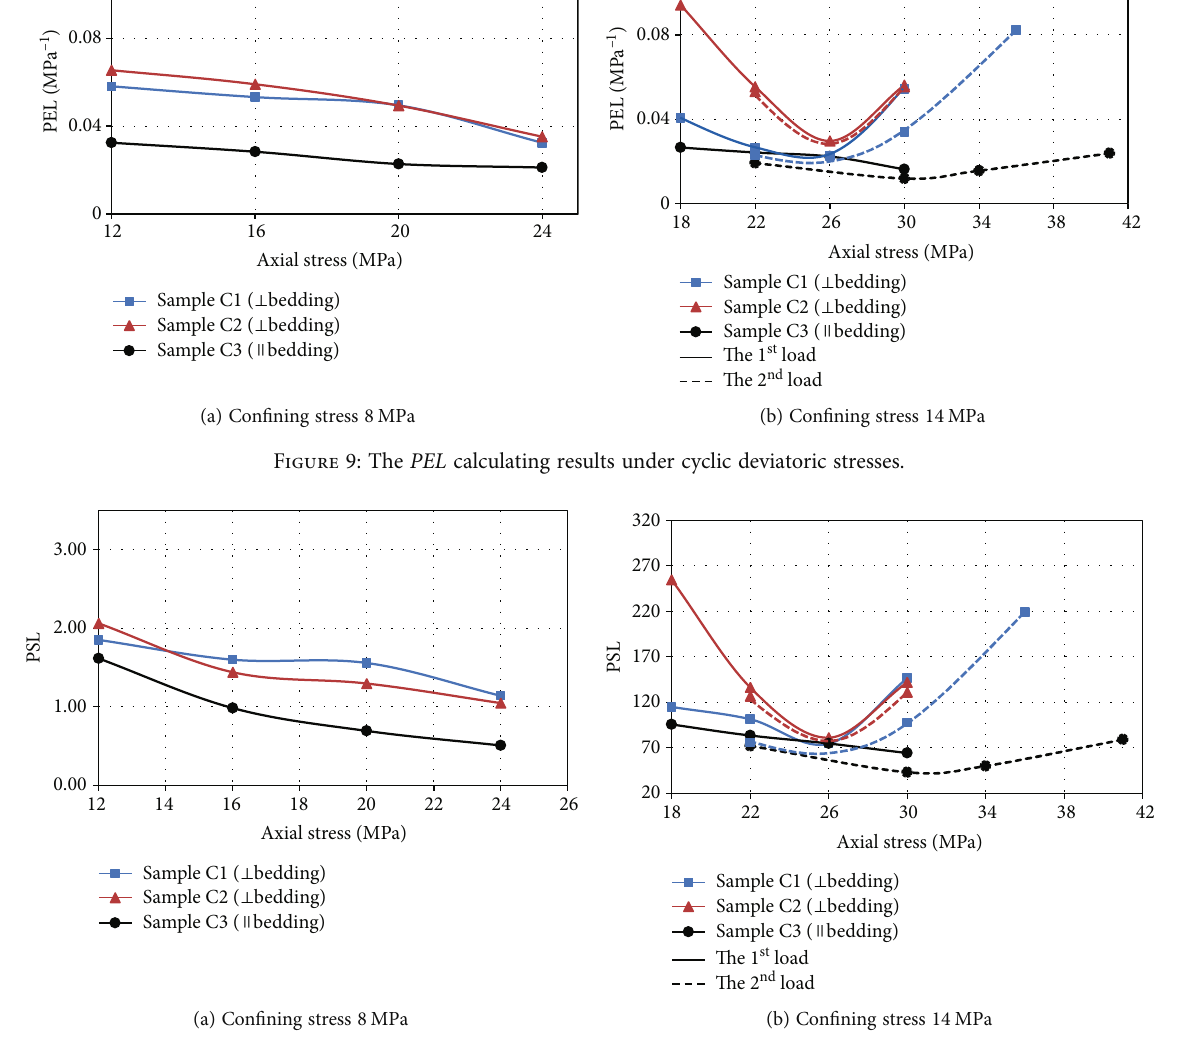
Figure 10: The PSL calculating results under cyclic deviatoric stresses.